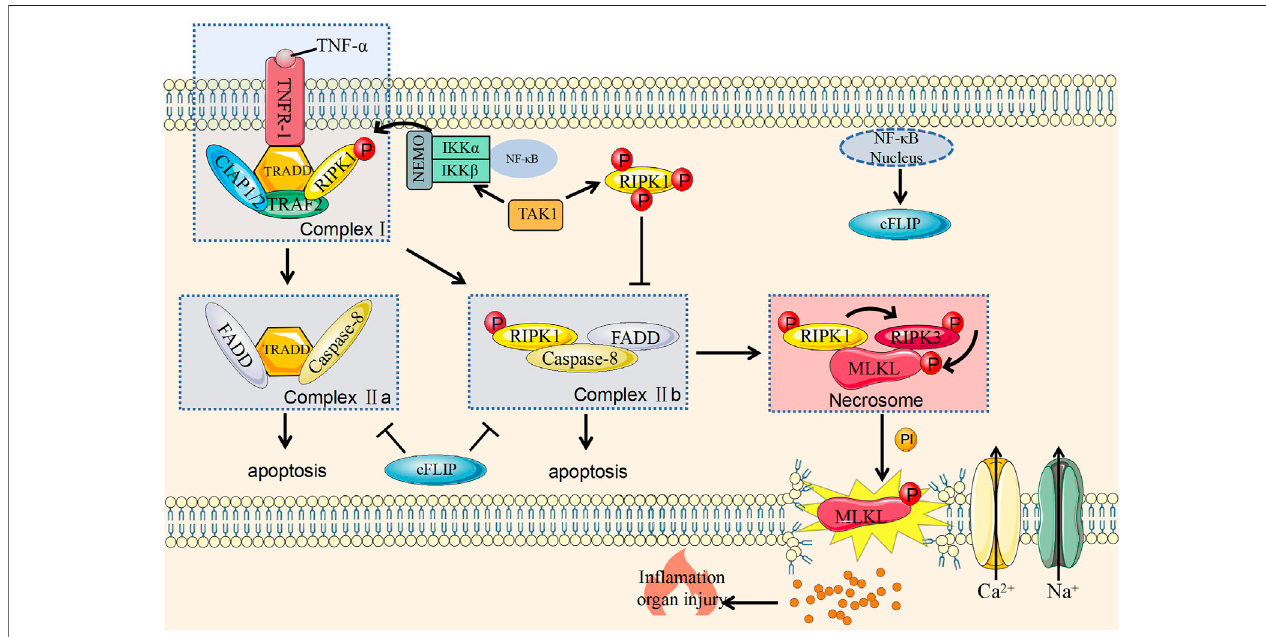
FIGURE 1 | Molecular mechanism of necroptosis and its regulation. Caspase-8, cysteine-aspartic proteases-8; cFLIP, cellular (Fas asscoiated deathe domain like IL-1 converting enzyme)/caspase-8 inhibitior protein; cIAP1/2, cellular inhibitor of apoptosis protein 1 and 2; FADD, Fas-associating protein with a novel death domain; IKK α ,I κ Bkinase α ;IKK β ,I κ Bkinase β ;IP,inositolphosphate;MLKL,mixedlineagekinasedomainlikepseudokinase;NEMO,nucleartfactor- κ Bessentialmodulator;NF- κ B, nuclear factor kappa-B; P, Phosphorylation; TNF- α , tumor necrosis factor- α ; TAK1, transforming grow factor-beita actived kinase 1; TNFR1, tumor necrosis factorreceptor1;TRADD,TNFreceptorassociateddeathdomain;RIPK1,receptorinteractingserine/threonineproteinkinase1;TRAF2,TNFreceptorassociatedfactor 2; RIPK3, receptor interacting serine/threonine protein kinase